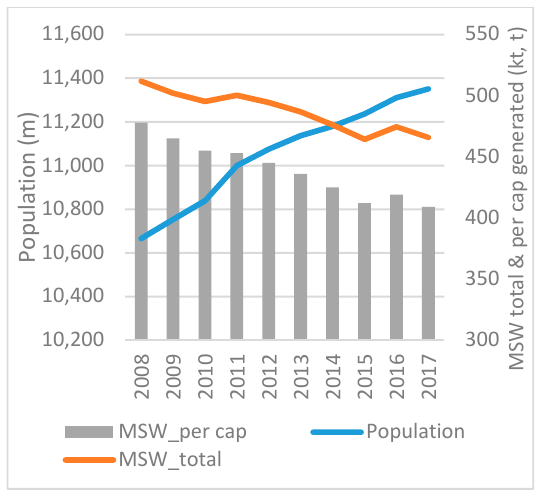
Figure 1. Population and MSW production in Belgium 2008–2017 (European Statistics 2019a, 2019c). Incineration without energy recovery (D10) has been used for treating small amounts of MSW, representing an average of 1.70%. Alternatively, incineration with energy recovery (R1) is the method that is widely used for waste treatment in Belgium, representing over 40% of the total waste generated (Figure 2). Soc. Sci. 2019 , 8 , x FOR PEER REVIEW